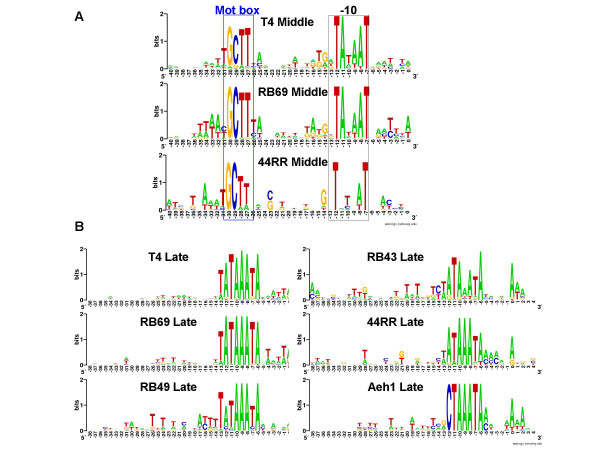
(A) Sequence logo representation of putative middle promoter consensus for RB69 and 44RR. Consensus was identified and plotted as in Figure 2. (B) Putative late promoter consensus for each genome. Consensus was identified as for early promoters, using fuzznuc and HMMer, except Aeh1, for which ELPH [37] and HMMer were used initially.